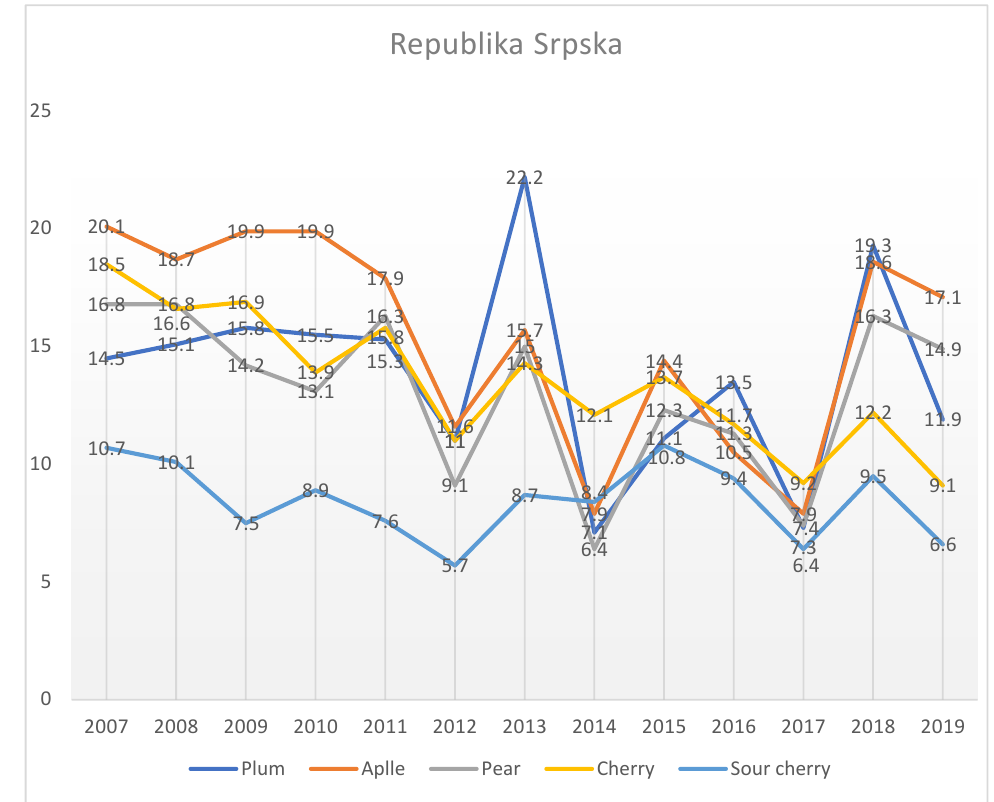
Figure 5. Fruit yield (in kg per tree) for certain fruit varieties in the Republika Srpska, period 2007–2019. (Data source: Republic Institute of Statistics Republika Srpska) [18].